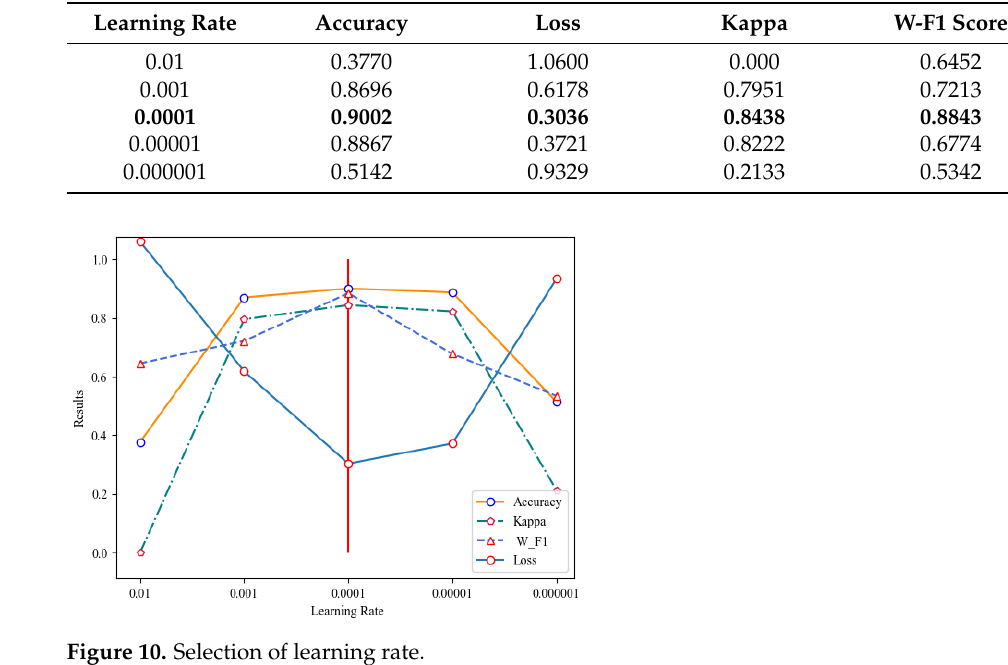
Table 6. Selection of learning rate.